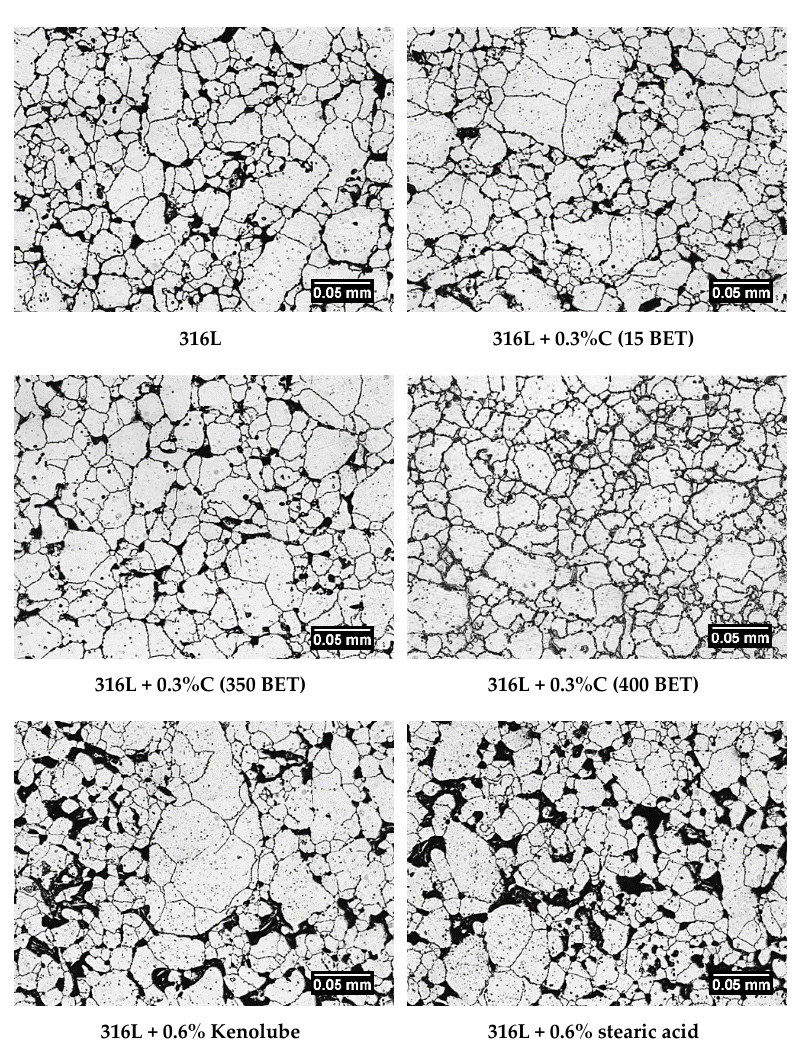
Figure 6. Example microphotographs of etched metallographic specimen surfaces showing the microstructure of sinters made from pure AISI 316L austenitic stainless steel powder and mixtures with the addition of 0.3 wt% of micrographite (15 m 2 /g BET), nanographite (350 m 2 /g and 400 m 2 /g), 0.6 wt% of Kenolube, and 0.6 wt% of stearic acid.